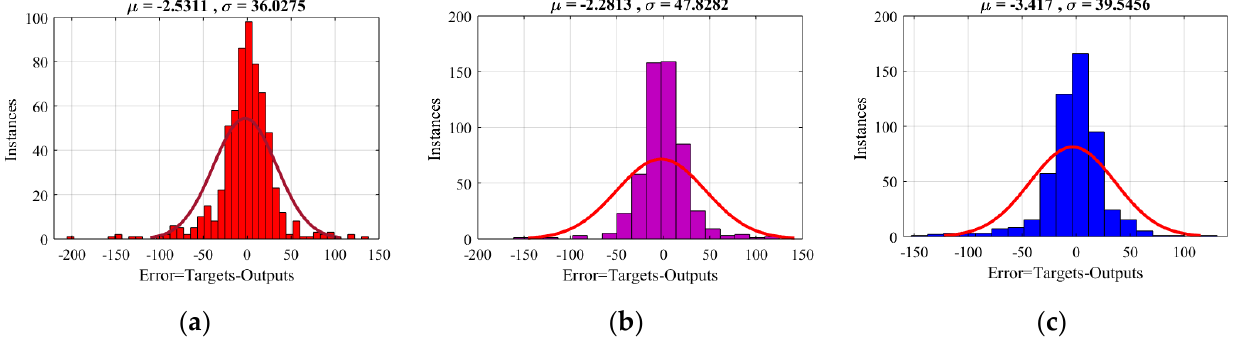
Figure 9. Error in predicting energy consumption for the ELM model at each time interval, in the form of an error histogram: ( a ) 2016–2017; ( b ) 2018; ( c ) 2019–2020.